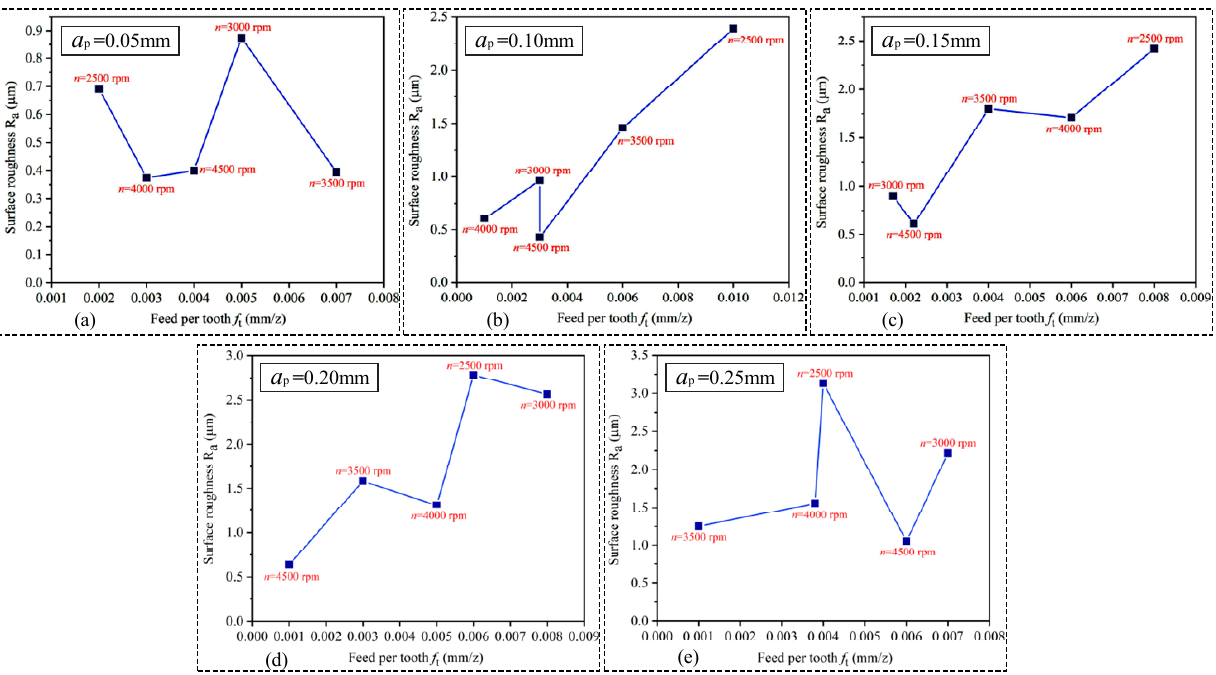
Figure 7. The effect of feed per tooth on surface roughness. ( a ) a p = 0.05 mm. ( b ) a p = 0.10 mm. ( c ) a p = 0.15 mm. ( d ) a p = 0.20 mm. ( e ) a p = 0.25 mm. Similarly, the contribution ratio based on the ANOVA was introduced to statistically investigate the relation between parameters and surface roughness. Table 9 shows the ANOVA analysis results for surface roughness. The results of variance analysis showed that the order of the significant influence on the surface quality is: spindle speed—1; milling depth—2; feed rate—3. Spindle speed n and milling depth a p are highly significant influencing factors (HS), and feed speed v f is a significant influence factor (S). The